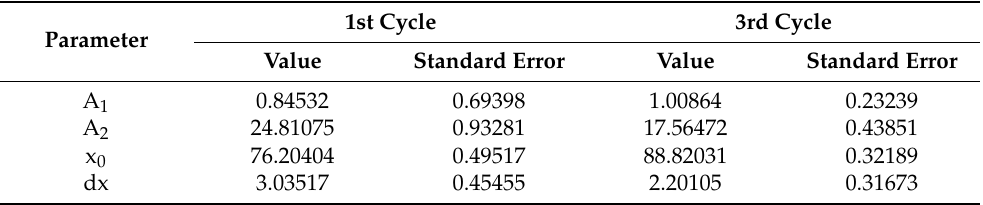
Table 1. Values of Boltzmann function parameters, according to the diagrams listed in Figure 5.